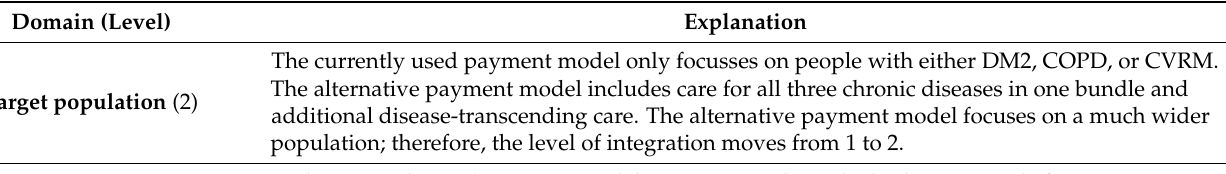
Table 4. Description of the level of integration expected to result from the proposed payment